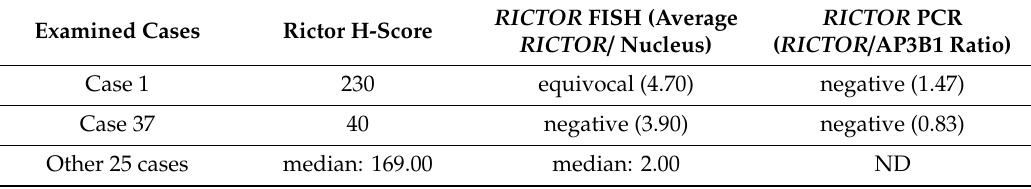
Table 2. The results of the RICTOR amplification analyses. The results of the amplification analysis in the examined 27 cases are presented. We found equivocal result in Case 1 using RICTOR FISH analysis, but ddPCR could not confirm RICTOR amplification in this case, nor in other studied samples (ND, not